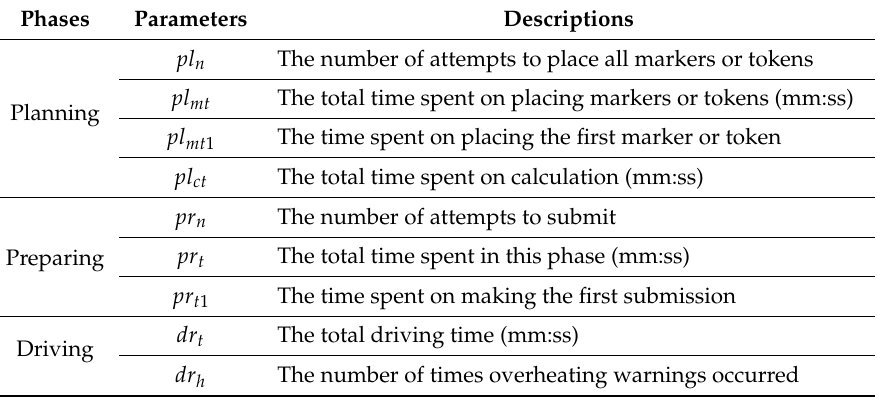
Table 3. Usability parameters used in our